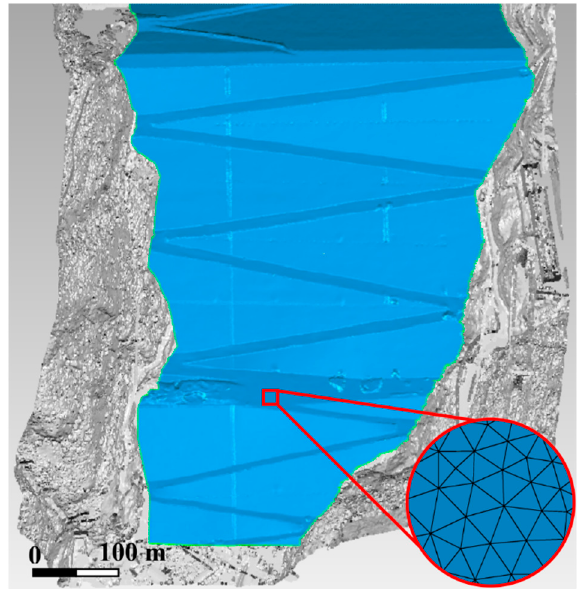
Figure 5. Triangulated irregular network (TIN) model of the Changheba dam.